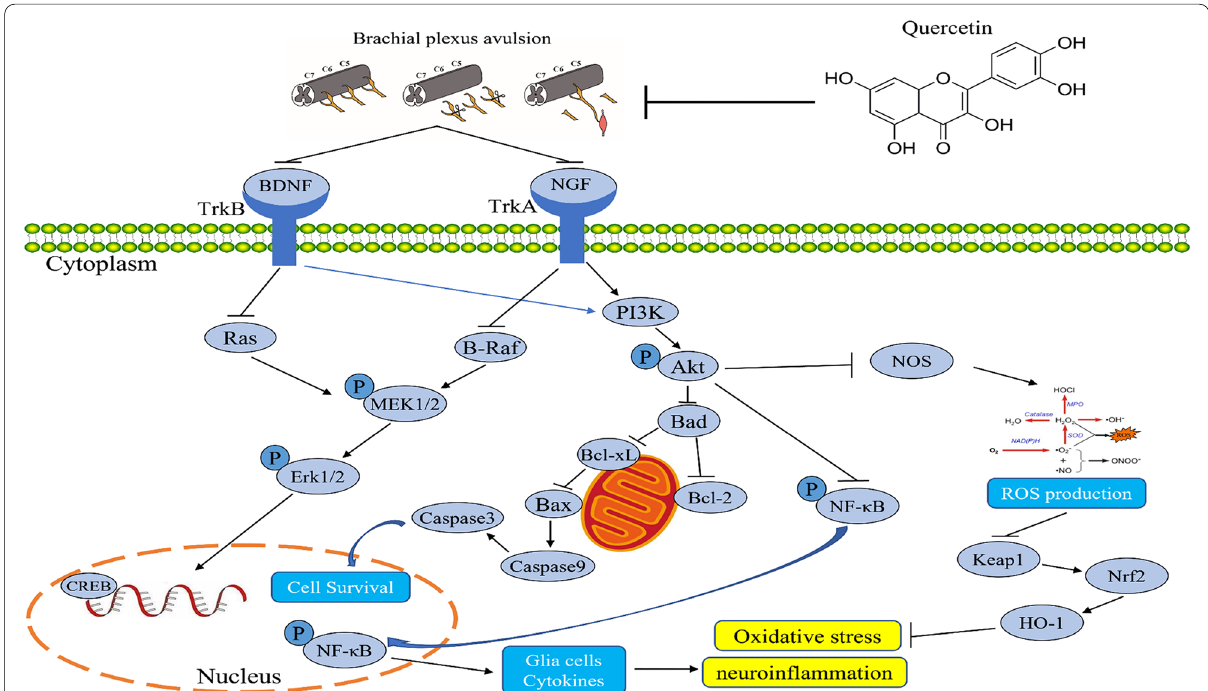
Fig. 9 Schematic illustration depicting the putative pathways associated with the therapeutic effect of QCN after BPA in rats. QCN significantly elevated survival and axonal regeneration of motoneurons and enhanced functional recovery after spinal root avulsion/reimplantation in rats. The neuroprotective effects of QCN might be attributed to the inhibition of neuroinflammatory response and oxidative stress, partially via activating neurotrophins, such as NGF and BDNF, and modulating the Akt and MAPK signaling